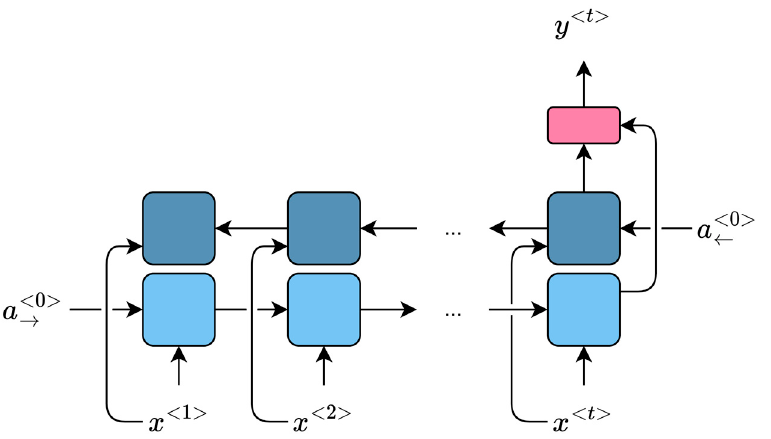
Figure 1. Many-to-one type of single-layer BiRNN unrolled over time. Here, 𝑥 (cid:2996)(cid:3047)(cid:2997) is the input at (cid:104) 0 (cid:105) (cid:104) 0 (cid:105) step t , y (cid:104) t (cid:105) is the output at time step t , and a → and a ← are activations at the initial time step in the time step 𝑡 , 𝑦 (cid:2996)(cid:3047)(cid:2997) is the output at time step 𝑡 , and 𝑎 →(cid:2996)(cid:2868)(cid:2997) and 𝑎 ←(cid:2996)(cid:2868)(cid:2997) are activations at the initial time forward and reverse directions of the RNN, respectively. step in the forward and reverse directions of the RNN, respectively.